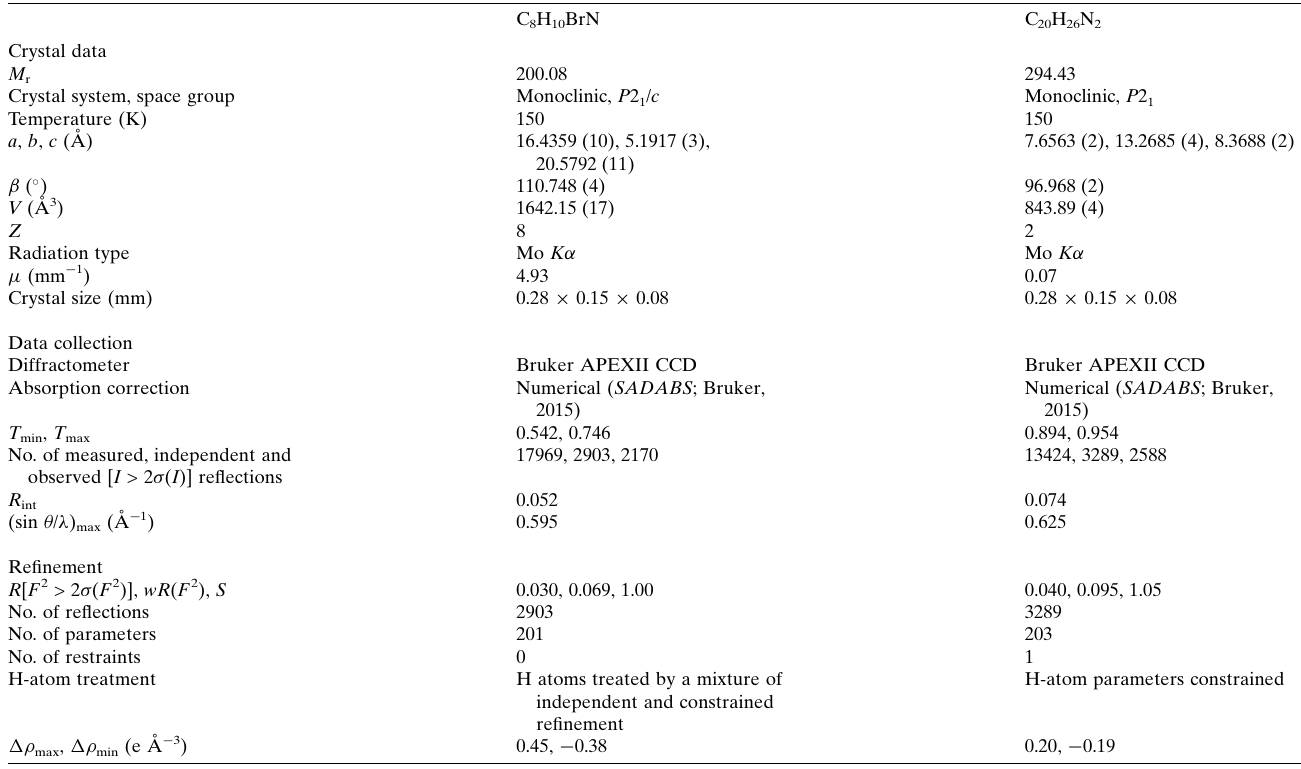
Table 2 Experimental